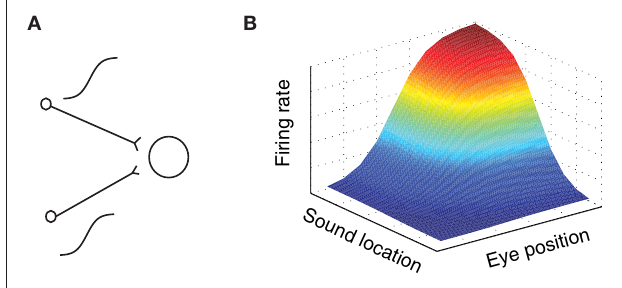
FIgure 3 | gain field coding of eye position and sound source location. (A) Gain field network, in which a target neuron directly receives eye position and auditory inputs, illustrated here as sigmoidal in shape. The response of a simulated target neuron for multiplicative interactions is shown in (B) . The response is characterized by a systematic combination of both inputs. In principle, input signals need not be sigmoidal and the interaction could be either additive, multiplicative, or a combination of the